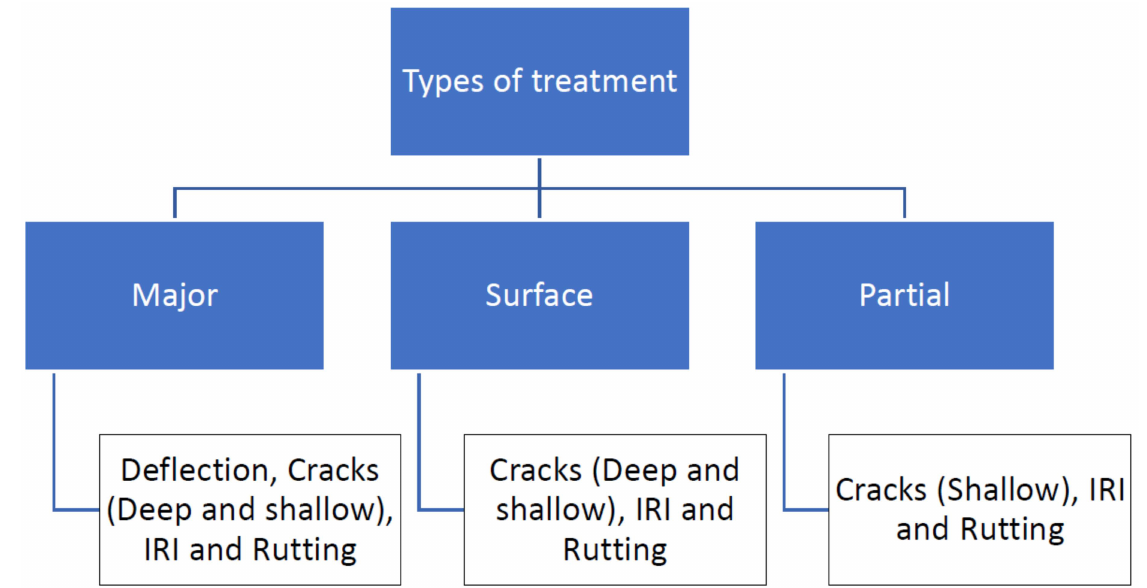
Figure 5. Types of maintenance treatment.